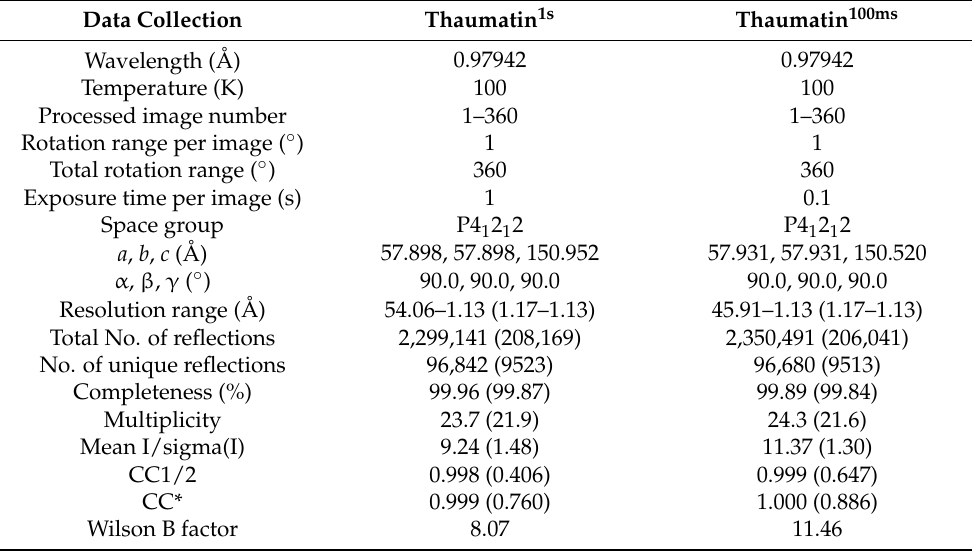
Table 1. Data collection and refinement statistics.